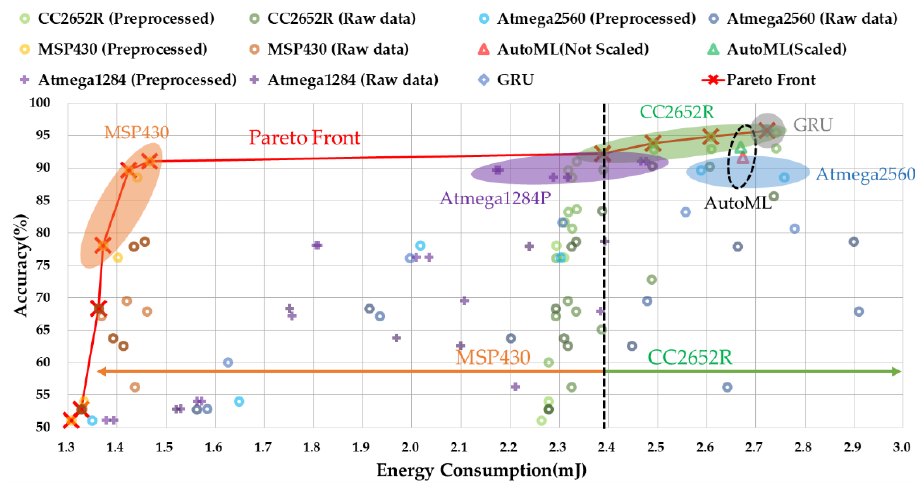
Figure 11. Pareto curve between energy consumption and accuracy for four types of MCUs.